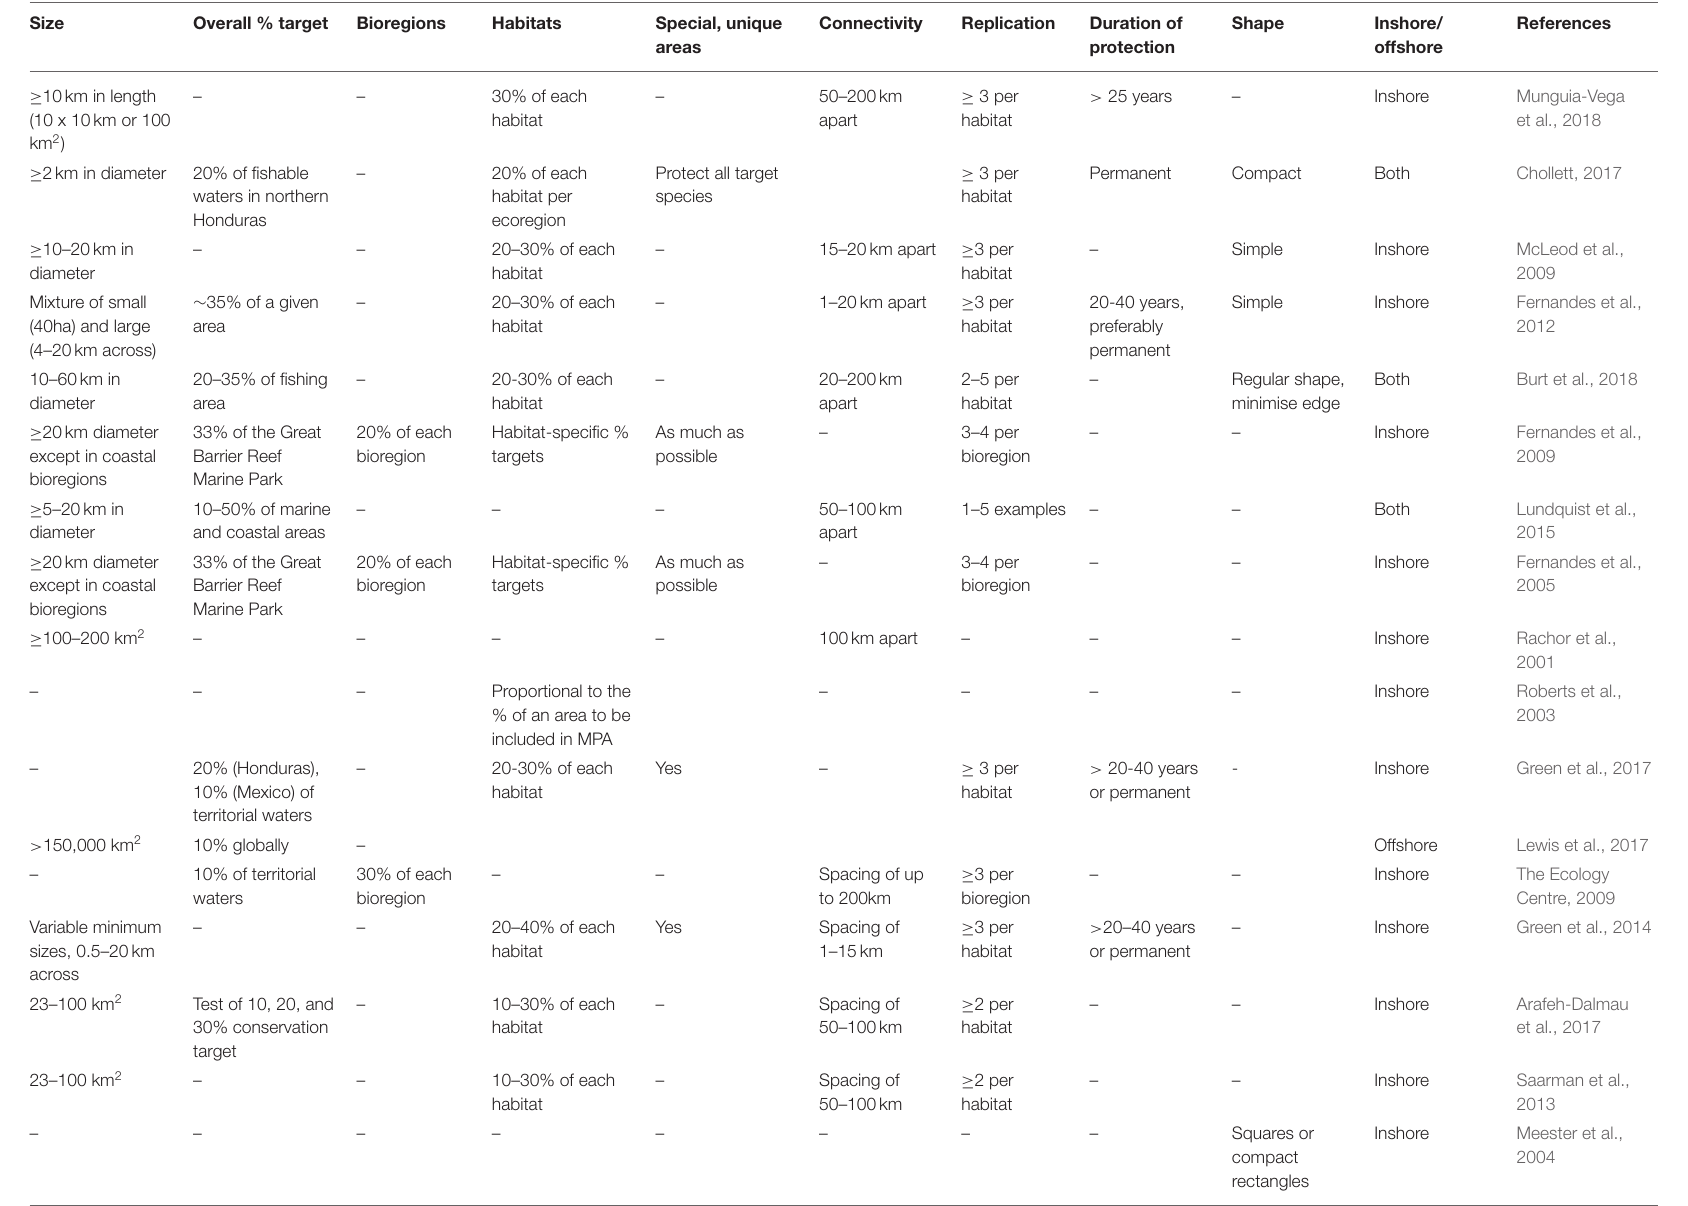
TABLE 3 | Summary of specific and quantitative MPA network design